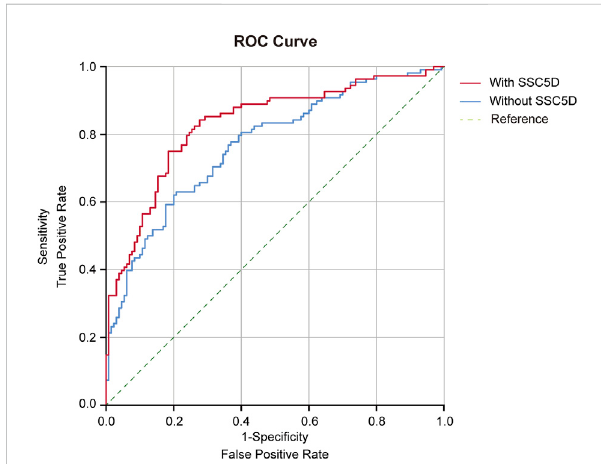
FIGURE 4 Receiver operating characteristic (ROC) curve with area under thecurve(AUC) forModel2withSSC5DorwithoutSSC5D.Redcurve: ROC curve for Model 2 with SSC5D; Blue curve: ROC curve for Model 2 without SSC5D; Green curve: Reference. Model 2: sex, age, BMI, diabetes mellitus, hypercholesterolemia, hypertension, hemoglobin, creatinine, LDL-c, hs-CRP, BUN, HbA1c, and eGFR.